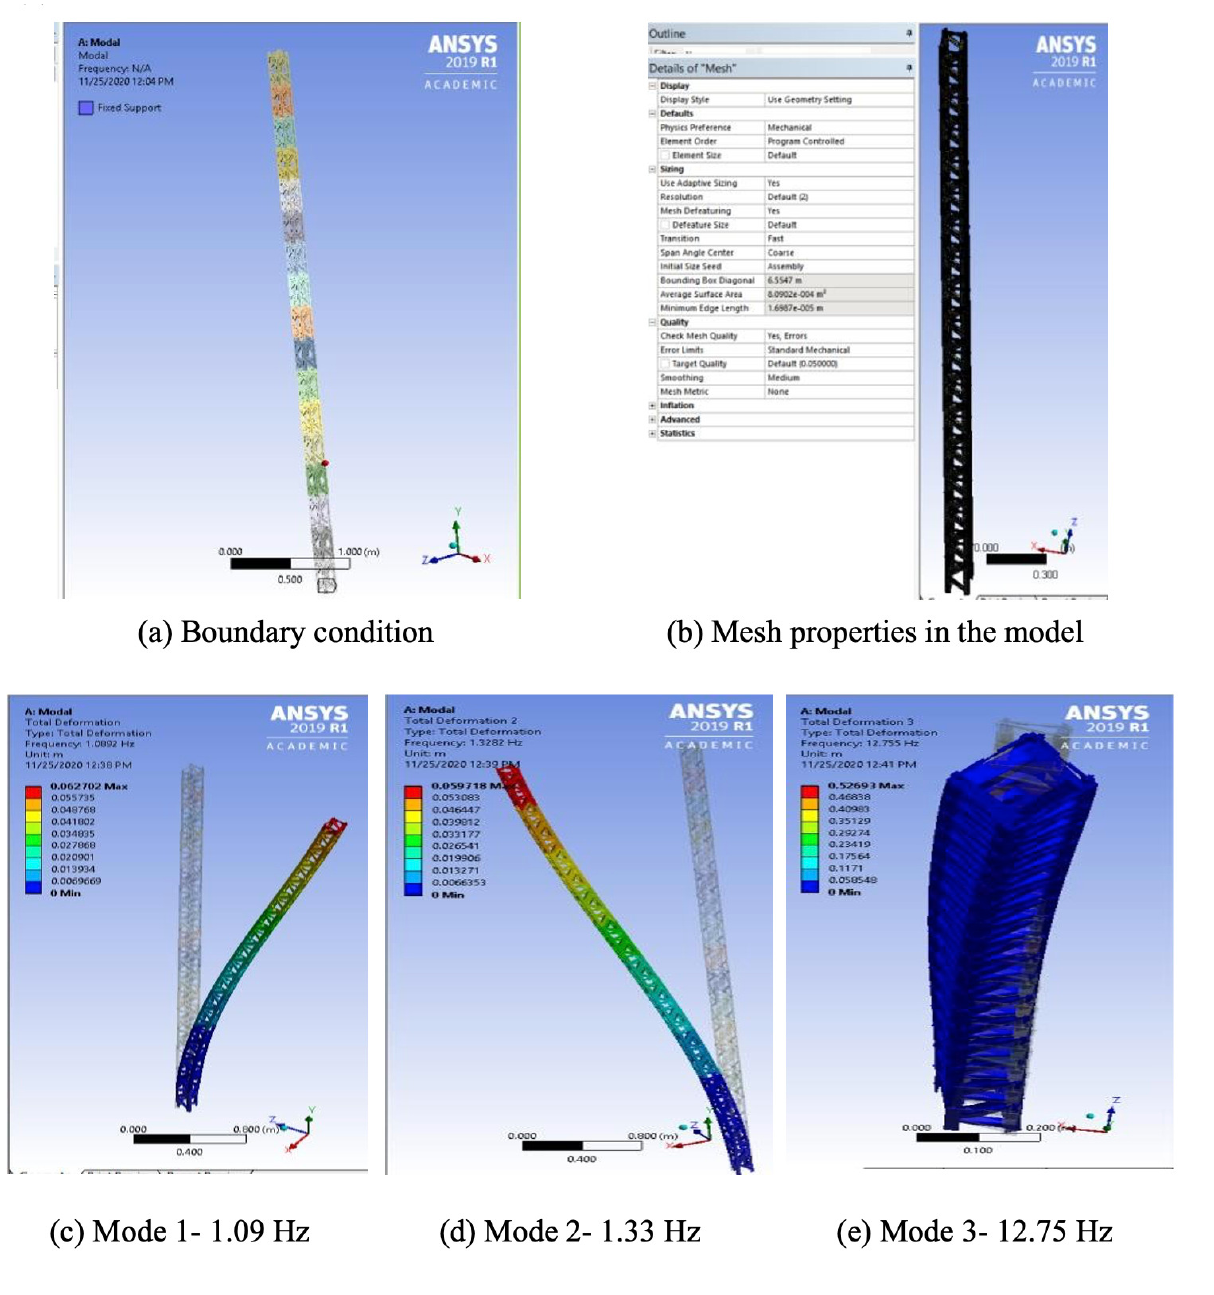
Figure 7. Modal parameters of